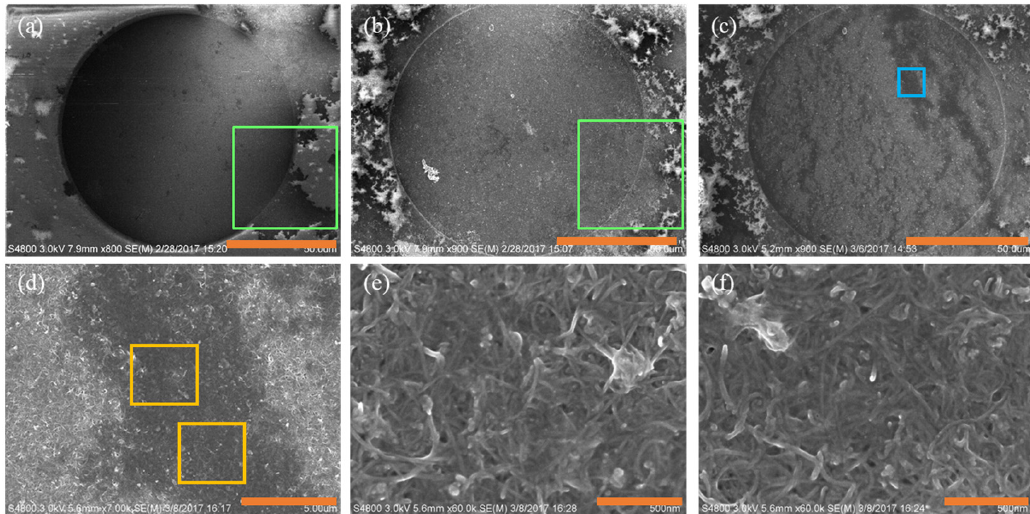
Figure 3 for the three types of BDUNCD microelectrodes in a 100 µ M DA solution at a flow rate of 0.2 mL/min. Table 1 summarizes the important measured FSCV parameters of the microelectrodes. The peak oxidation current (I pa ) that is commonly used as the detection sig- nal was ~10-fold higher for the nafion–MWCNT–modified BDUNCD microelectrode than that of the unmodified BDUNCD microelectrode. The nafion coating on the unmodified BDUNCD surface demonstrated a ~4-fold higher current than that of the unmodified micro- electrode. The oxidation peak potential (E pa ) marginally increased from 0.78 ± 0.01 V for unmodified BDUNCD surfaces up to 0.94 ± 0.01 V for nafion–MCNCT-modified BDUNCD surfaces. The large increase in the current signals (and a higher sensitivity) is due to a significant increase in the electroactive area and sites achieved via MWCNT coating [36,39] and the anionic nature of nafion that is expected to adsorb the positively charged DA [18,40]. The results suggested the importance of coating both nafion and MWCNT for improving the overall sensitivity of diamond microelectrodes. The next question to investigate is whether the two-coating modification strategy can provide adequate sensitivity and selectivity long- term. For this, we employed a microfluidic setup to thoroughly characterize the three BDUCND microelectrode types using droplet microfluidics that mimics neurochemical discharges in the extracellular space of the brain [41].